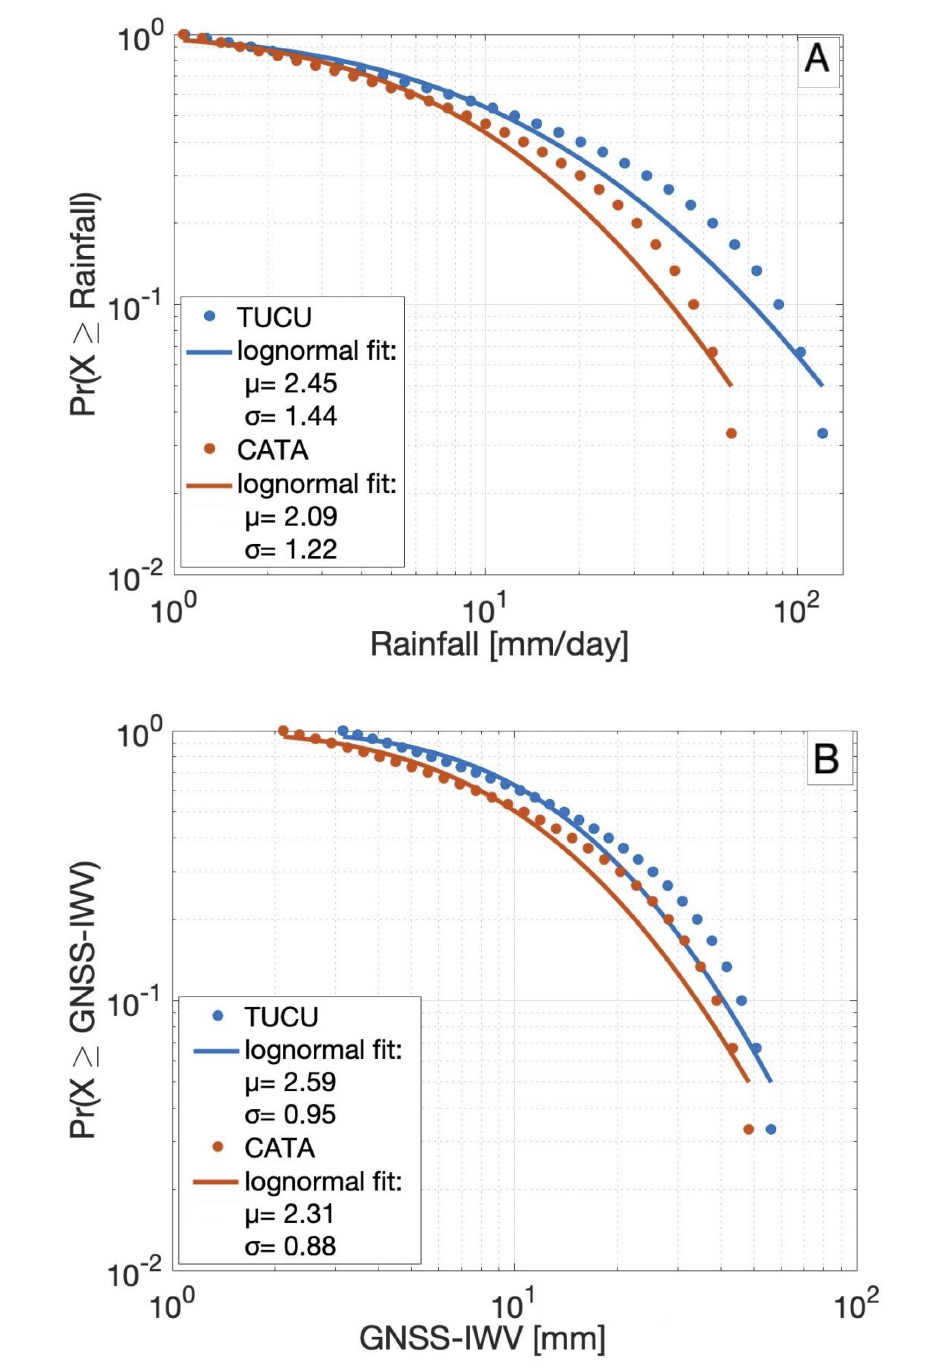
Figure 2. Logarithmically binned rainfall data ( A ) and GNSS-IWV ( B ) for TUCU station (blue dots) and for CATA station (red dots). The fitting parameters of the lognormal distribution (see Equation (11)) show the differences between two stations (2008–2013). Note that the tail of the distribution exhibits power-law behaviour starting at x min = 12.9 and with the estimated exponent α = 2.5 for the TUCU station and x min = 28 and the estimated exponent α = 2.9 for the CATA station. Based on the approach described by Aaron Clauset [50], we fit the power-law distribu- tion to CAPE data using a maximum likelihood estimator. Relying on the goodness-of-fit parameter, we observe that a power law is a plausible hypothesis for the CAPE